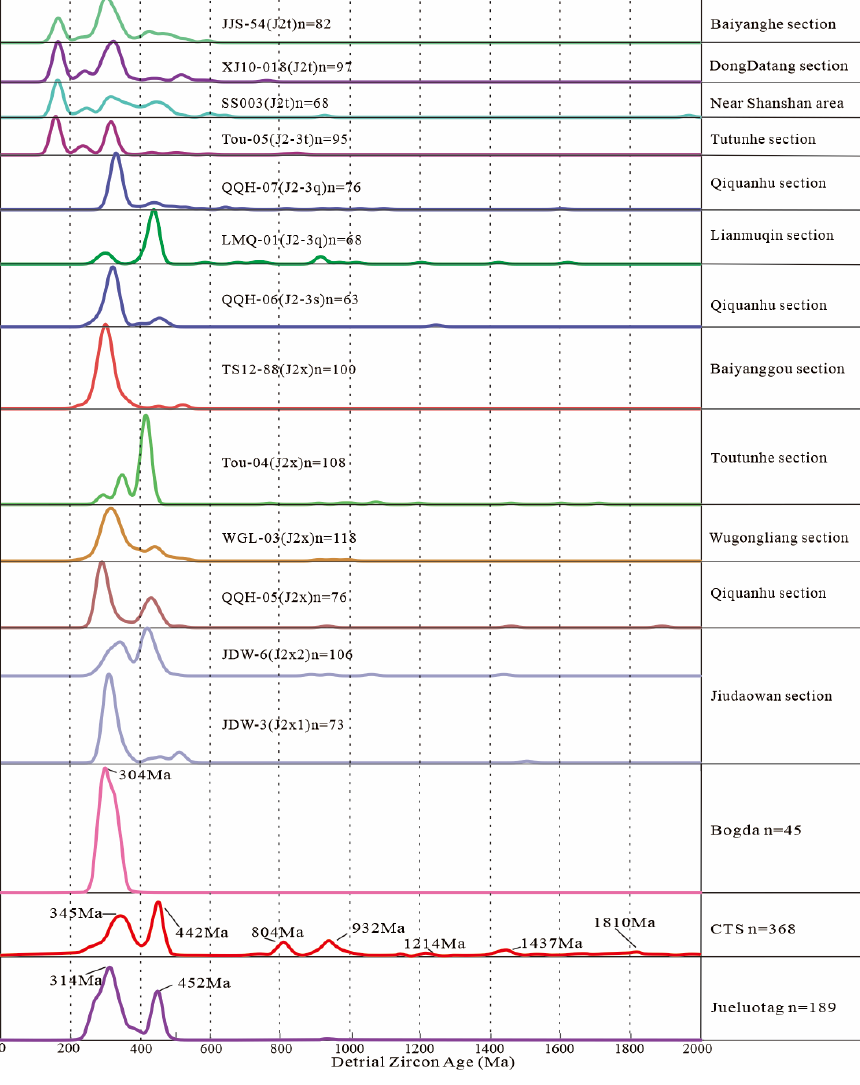
Figure 8. RelativeprobabilitymapofU-PbagesofMiddleJurassicdetritalzircons(datafrom[23,24,26,33,35,43,63]); Figure 8. Relative probability map of U-Pb ages of Middle Jurassic detrital zircons (data from for map locations, see Figures 1c and 3. Age spectra of potential-source-area features (data from [64,65,68,74] [23,24,26,33,35,43,63]); for map locations, see Figures 1c and 3. Age spectra of potential-source-area and references therein). features (data from [64,65,68,74] and references therein).